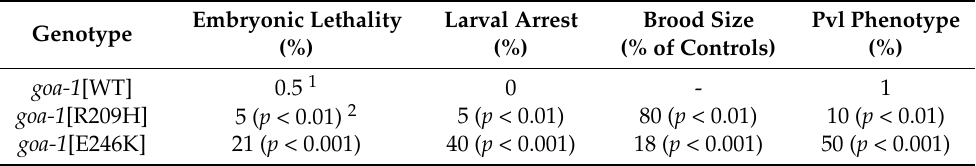
Table 1. Biallelic goa-1 mutations exhibit a variable degree of developmental